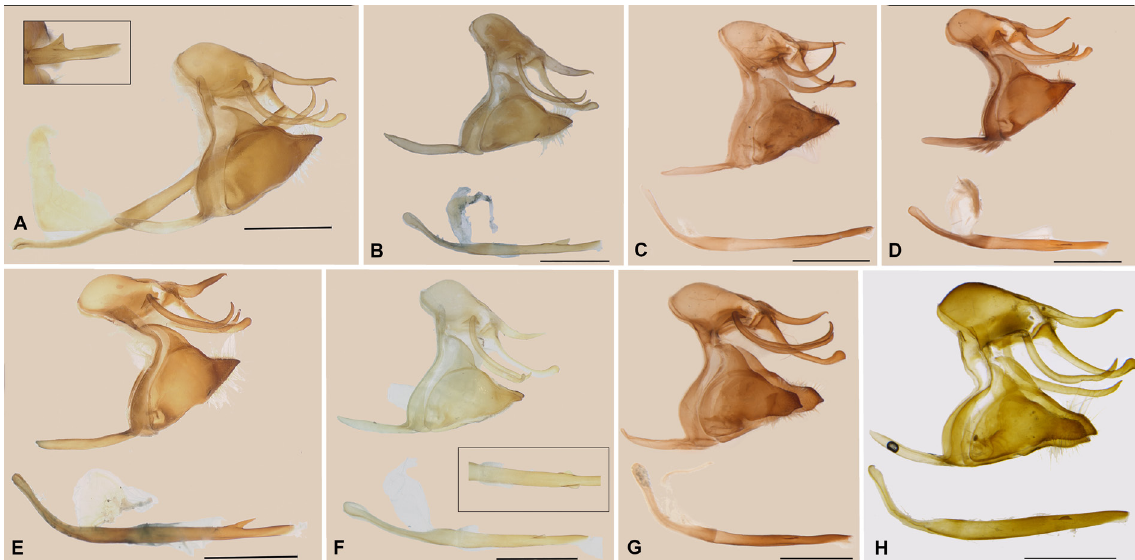
Fig. 4. Zischkaia “ pacarus clade”, male genitalia. A . Z. amalda (Weymer, 1911), lectotype, ♂, lateral view, with phallus separated (winglet on aedeagus shown inside rectangle) (Genitalic vial: SN-17- 21). B . Z. arctoa Nakahara, sp. nov., ♂, lateral view, with phallus separated (Genitalic vial: SN-17-9). C . Z. chullachaki Nakahara & Zacca, sp. nov., ♂, lateral view, with phallus separated (Genitalic vial: DZ 21. 235). D . Z. baku Zacca, Dolibaina & Dias, sp. nov., ♂, lateral view, with phallus separated (Genitalic vial: DZ 5. 573). E . Z. arenisca Nakahara, Willmott & Hall, sp. nov., ♂, lateral view, with phallus separated (Genitalic vial: SN-17-16). F . Z. argyrosflecha Nakahara, L. Miller & Huertas, sp. nov. ♂, lateral view, with phallus separated (two winglets on aedeagus shown inside rectangle) (Genitalic vial: M-9142 ♂, Lee D. Miller). G . Z. pacarus (Godart, [1824]), ♂, lateral view, with phallus separated (Genitalic vial: DZ 5. 578). H . Z. abanico Nakahara & Petit, sp. nov., ♂, lateral view, with phallus separated (Genitalic vial: 575/19.07.2017, J. Lorenc-Brudecka, MZUJ).